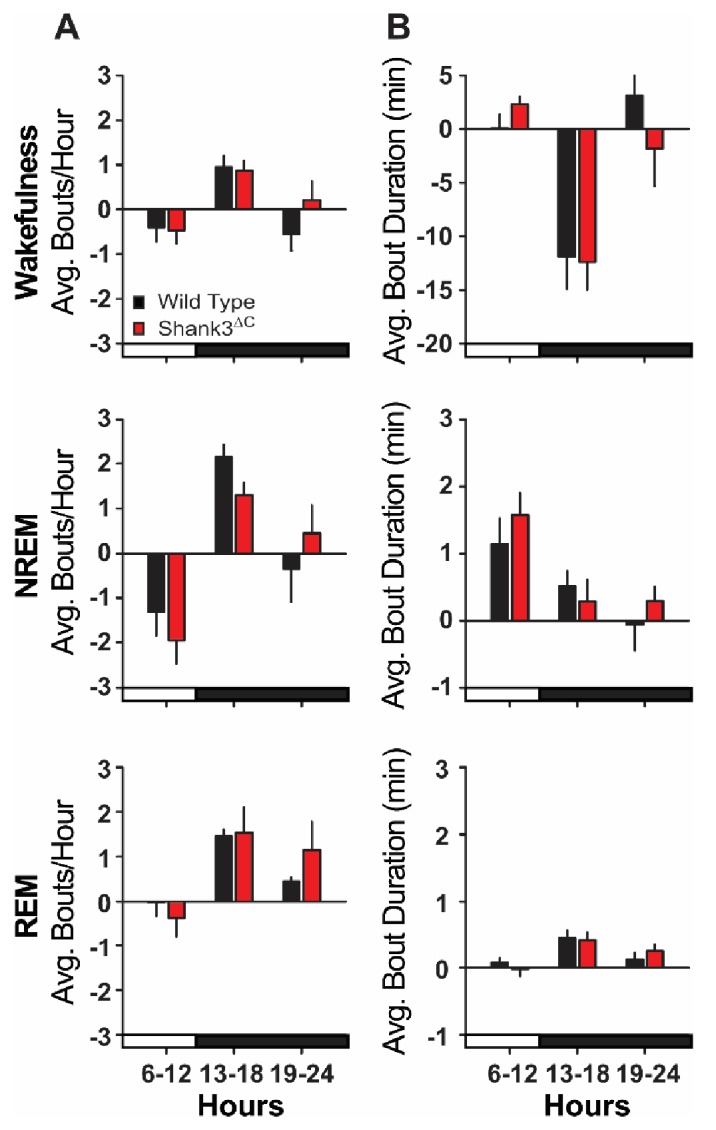
Bout analysis after sleep deprivation.(A) Average number of state-specific bouts per hour (difference scores) shown in 7 hr (remaining light period) and 6 hr blocks. (B) Average bout duration (min) per hour (difference scores) shown in 7 hr (remaining light period) and 6 hr blocks. Difference scores were calculated by subtracting baseline (BL) values from sleep deprivation (SD) values. Repeated measures ANOVA. Values are means ± SEM for wild type (n = 10) and Shank3∆C (n = 10) mice. Significance as p<0.05.